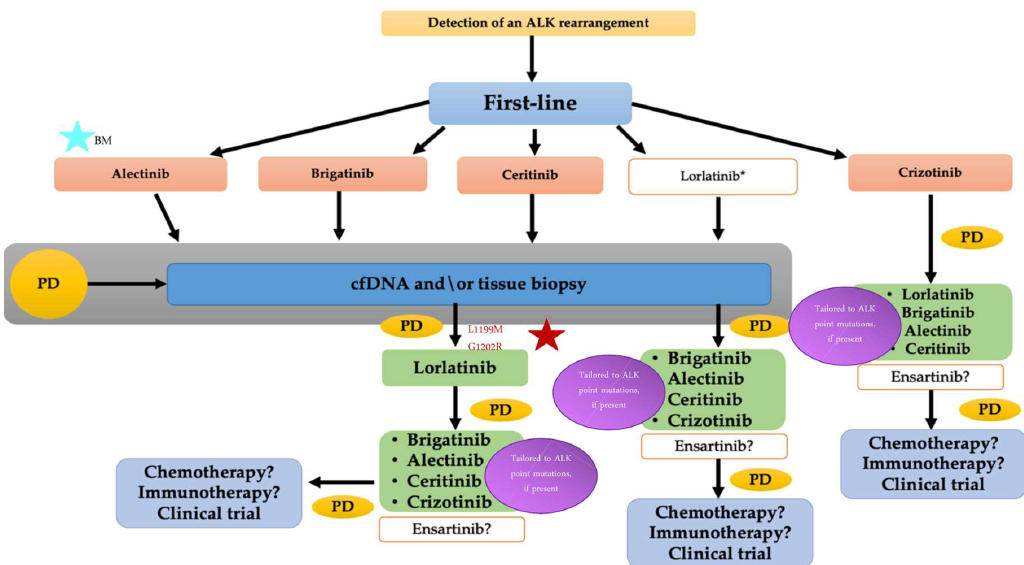
Figure 1. Proposed treatment algorithm for ALK-rearranged advanced NSCLC. Abbreviations: ALK, anaplastic lymphoma kinase; cfDNA, circulating-free DNA; PD, progressive disease; BM, brain metastases.